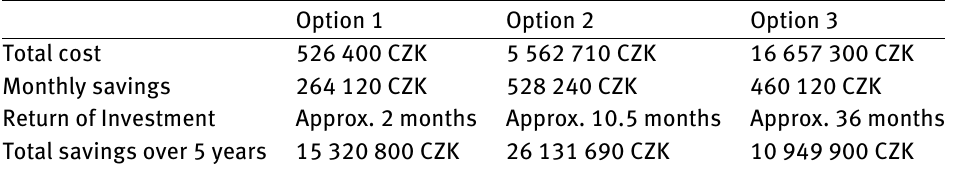
Table 1: Final costs of individual solutions – Options